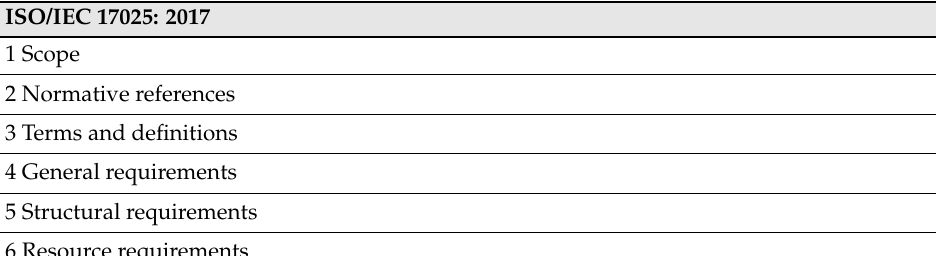
Table 1. ISO/IEC 17025 Standard Structure. Points that apply to specific technical aspects of non- targeted and suspect screening approaches that are discussed in this work are in Section 7—Process requirements, Sections 7.2, 7.6, 7.7, 7.8, and 7.11, indicated in